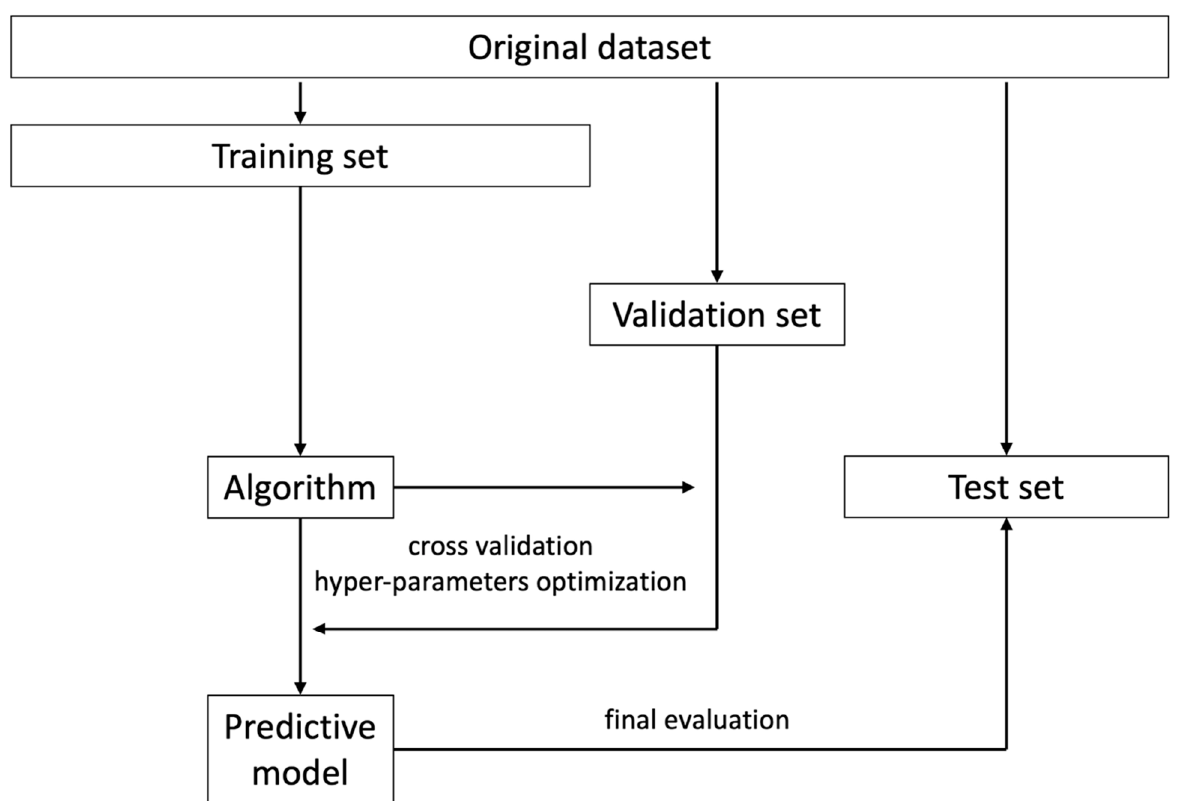
Figure 3. A flow diagram depicting the process of model training, validation, and testing using a single-institution dataset with holdout.